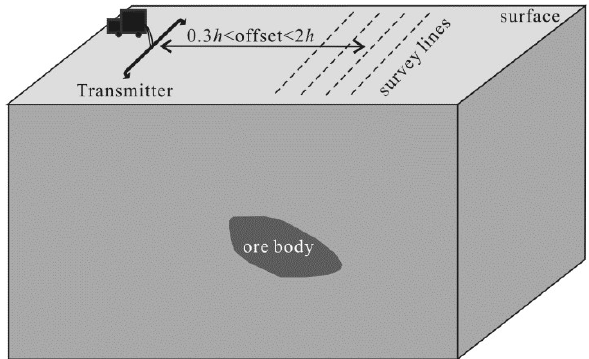
Figure 1. Diagram of SOTEM method. The grounded-wire source is parallel to the survey lines at a distance (offset) of approximately 0.3–2 times the maximum detection depth ( h ).